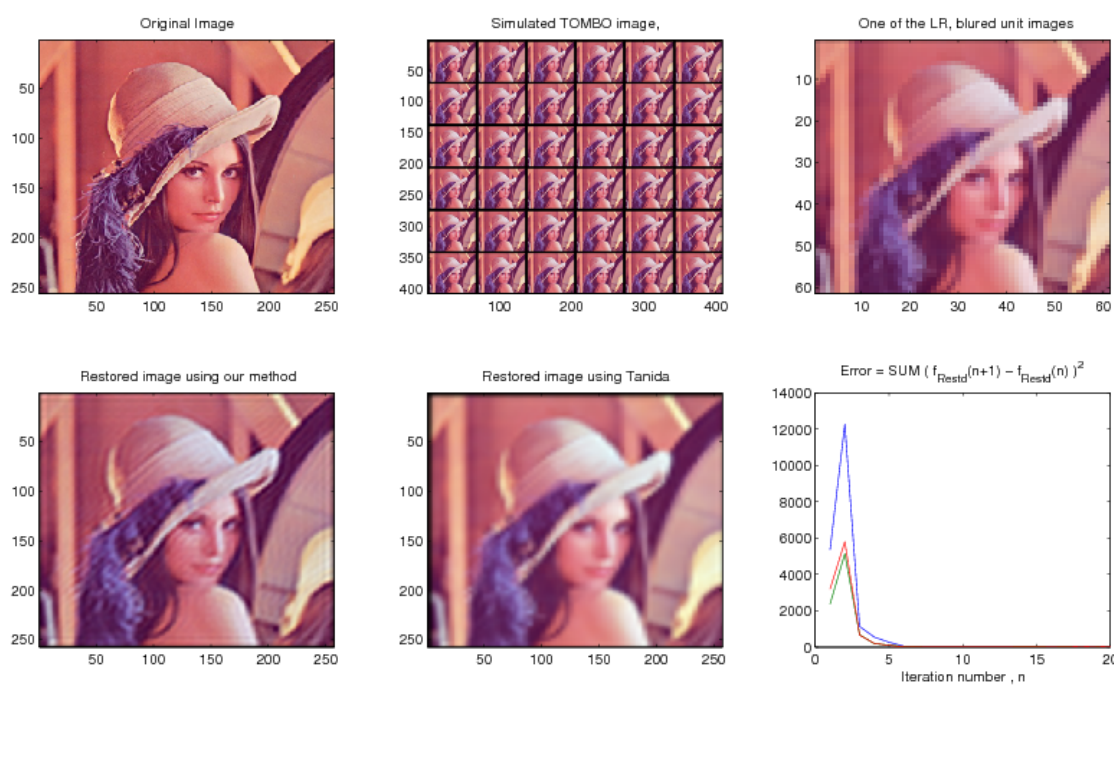
Figure 4. Simulation results, 6 × 6 images, D = 4 , L = 4 , ‘ = 7 , no additive noise.